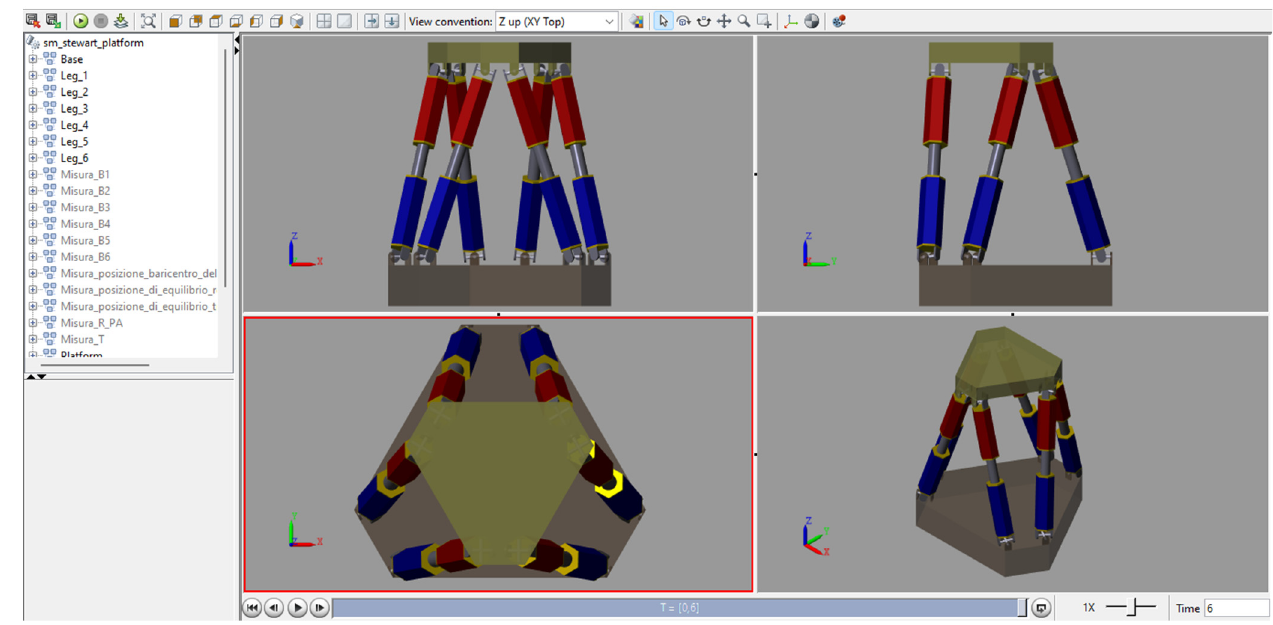
Figure 2. Multibody model of the Stewart platform.